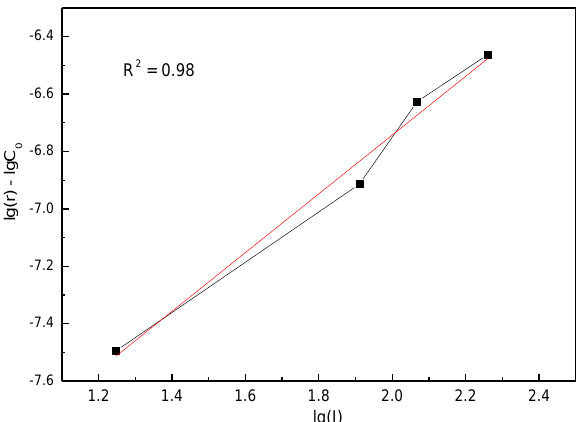
Figure 12. Regression of reaction kinetics data under simulated concentrating light.